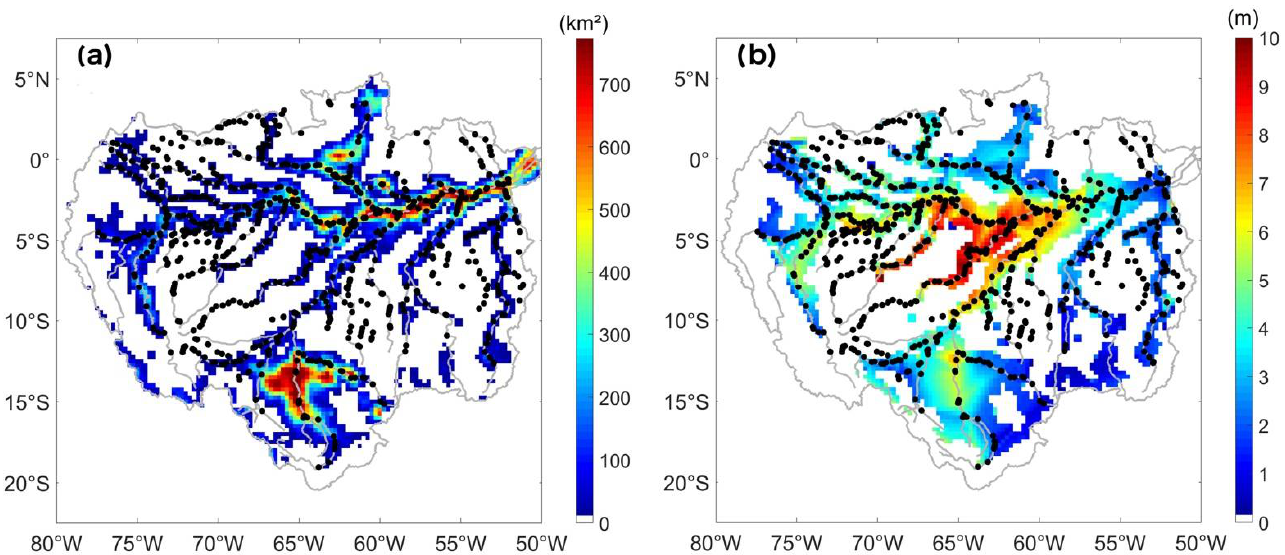
Figure 2. ( a ) Map of annual maximum surface water extent averaged over 1992–2015, for each 773 km 2 pixel from the Global Inundation Extent from Multi-Satellite (GIEMS-2) over the Amazon basin. ( b ) Map of averaged (2003–2010) monthly surface water level obtained from a combination of GIEMS surface water extent and ENVISAT water level. The black dots show the locations of 900 ENVISAT Virtual Stations providing surface water level variations.